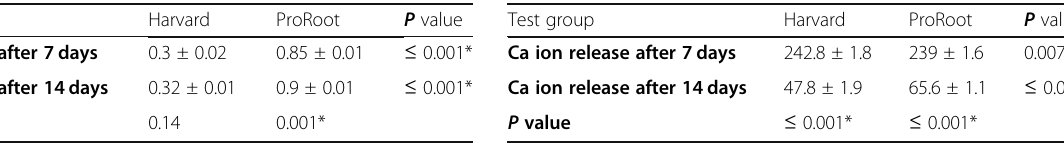
Table 3 Means and standard deviations of calcium ion release values after 7 and 14 days for the two tested cements stored in distilled